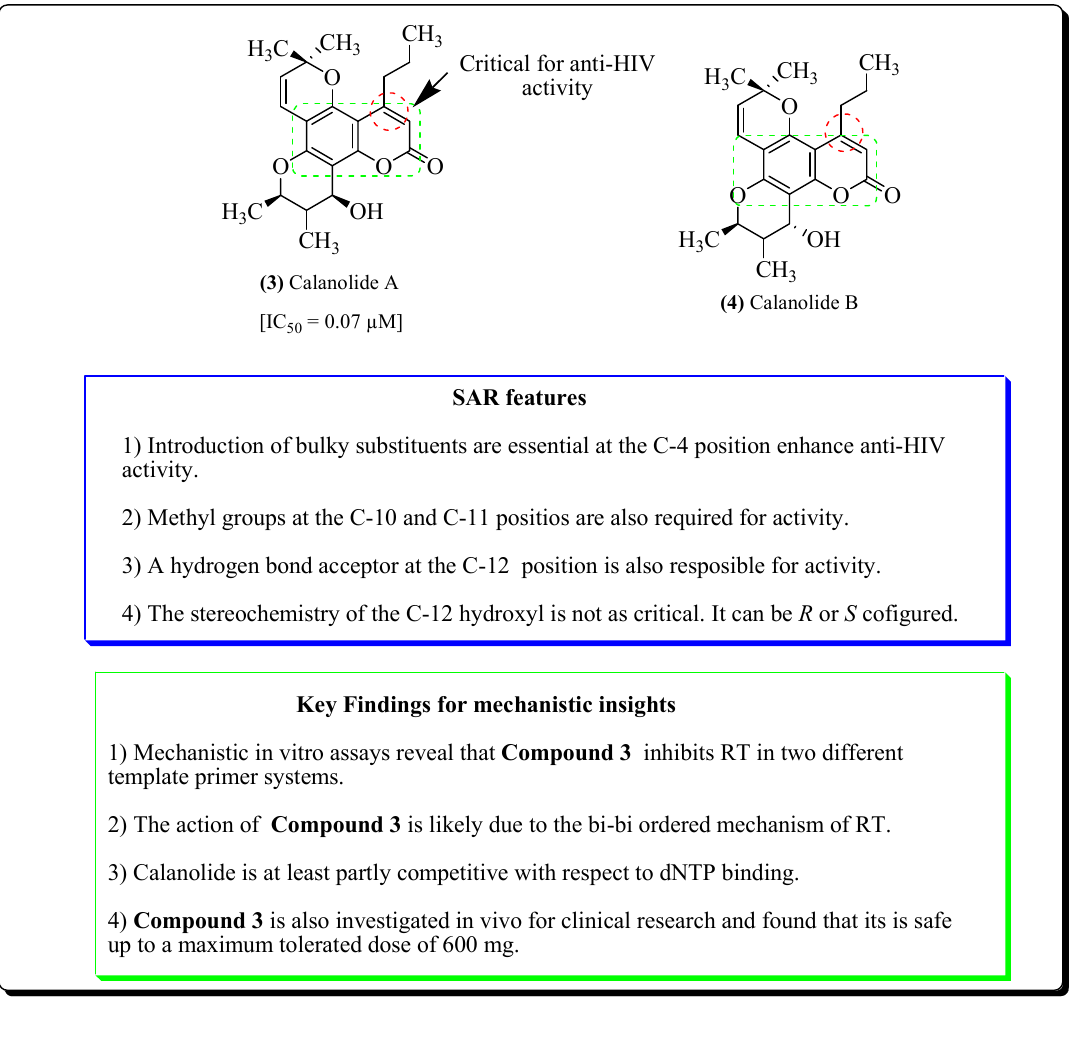
Figure 4. Structure-activity-relationshipsandimportantkeyfindingsofsomepotentreversetranscriptase (RT)